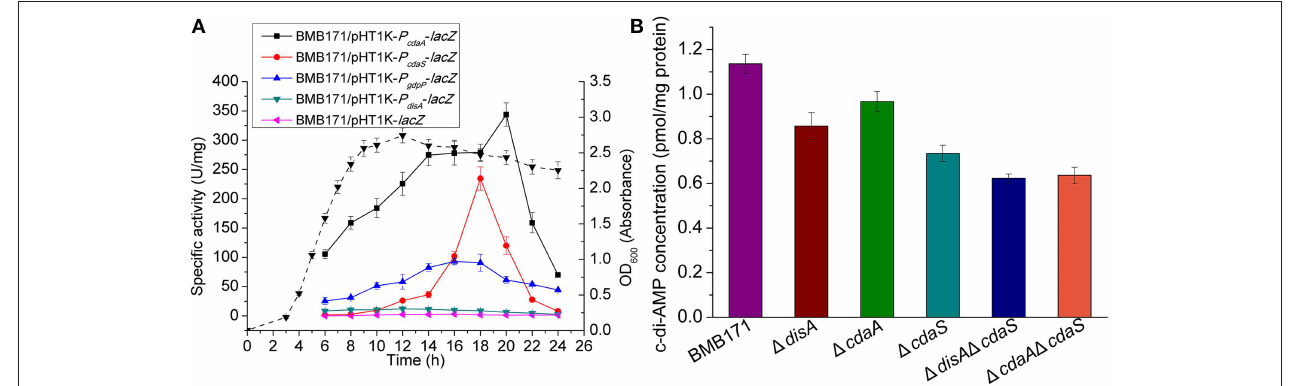
FIGURE 7 | (A) Transcription of genes encoding c-di-AMP metabolic enzymes. Strains were cultured in GYS medium at 28 ◦ C and BMB/pHT1K- lacZ was used as the negative control. β -galactosidase assays measuring the activities of c-di-AMP related gene promoters were measured. The dashed line represents the growth curve of BMB171/pHT1K- lacZ . (B) Intracellular levels of c-di-AMP. Strains were cultured in GYS medium at 28 ◦ C for 18h and extraction and measurement of c-di-AMP was performed as described in Materials and Methods Section. Data are represented as the mean of three independent experiments (error bar: